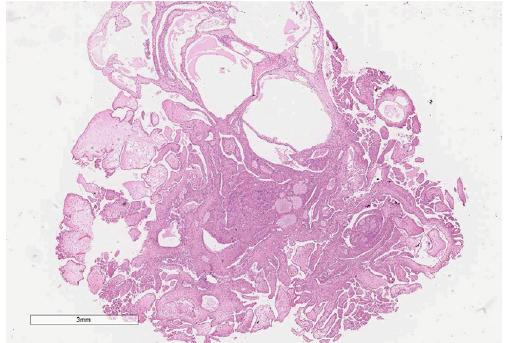
Figure 4: Papillae covered by several layers of columnar cells with moderate atypia. HyE